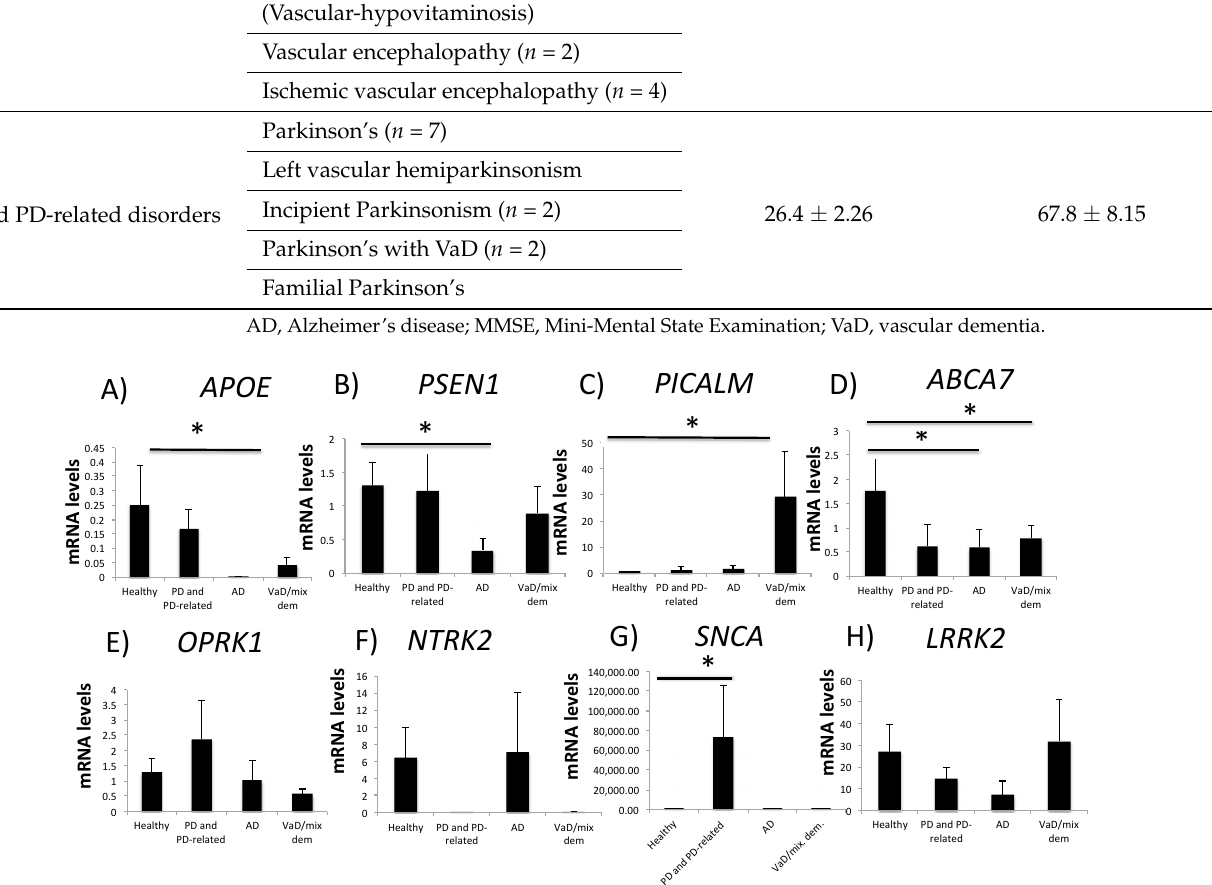
Table 1. Patient demographics and clinical diagnosis.